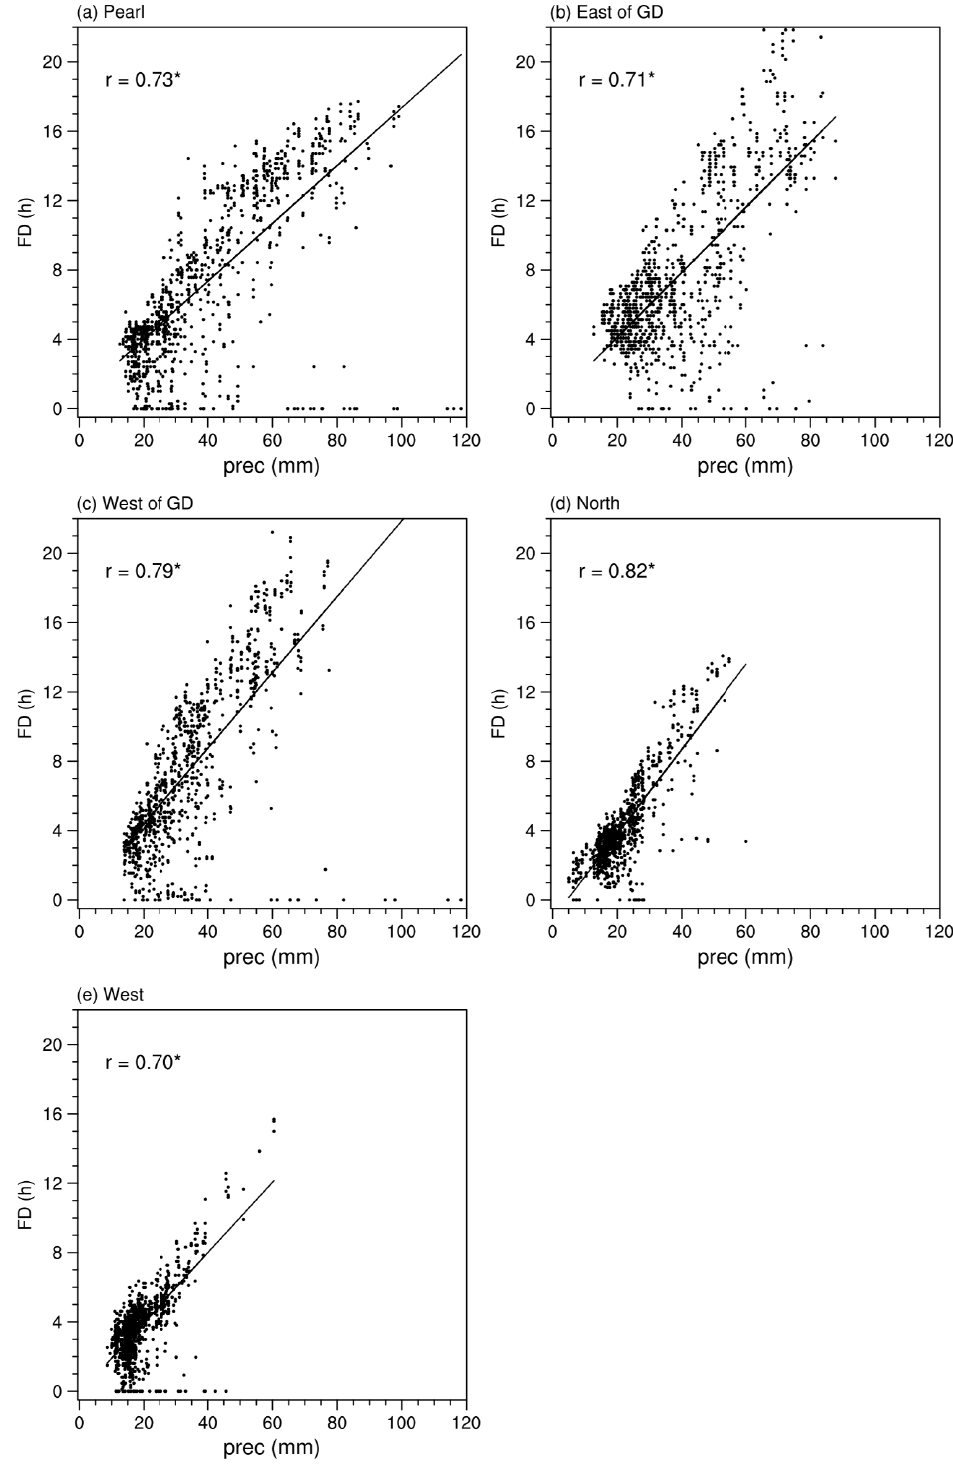
Figure 9. Scatterplots of precipitation and flood duration for the five classes of typhoon tracks. “*” indicate the correlation coefficient is above the 90% confidence